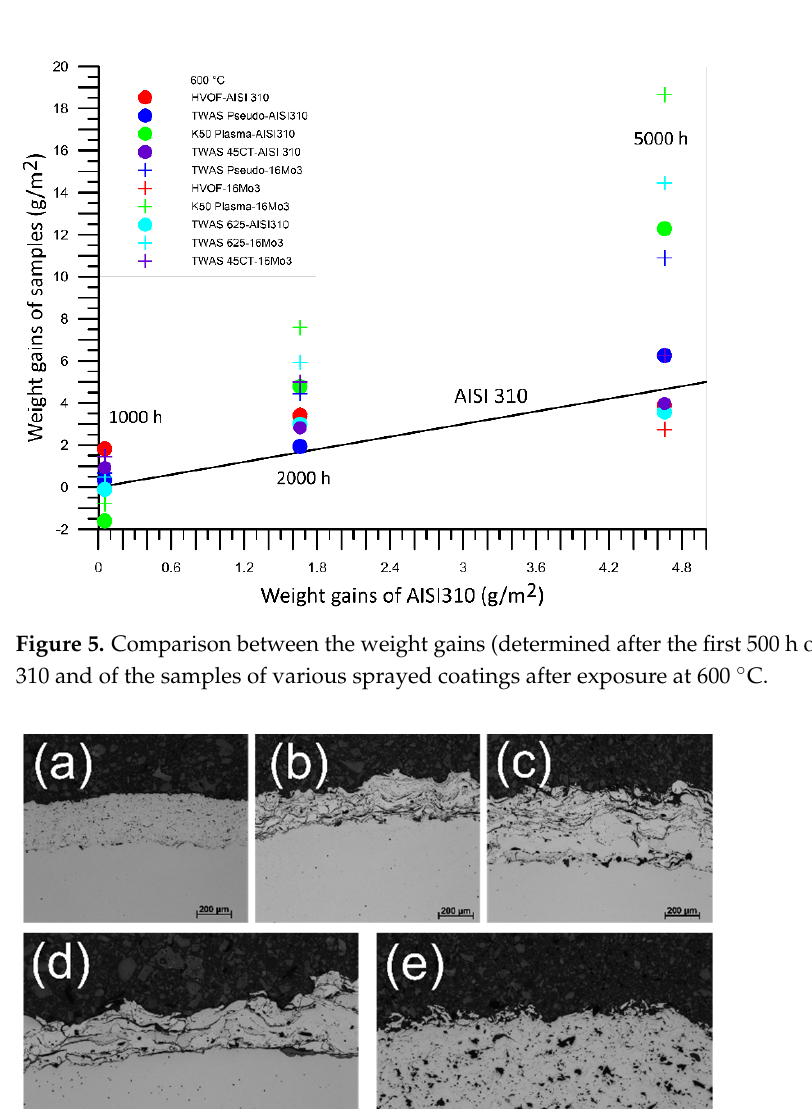
Figure 7. Optical light micrographs of the thermally sprayed coatings after 5000 h at 600 °C in model atmosphere: ( a ) HVOF Amperit 469, ( b ) TWAS 45CT, ( c ) TWAS Alloy 625, ( d ) TWAS pseudo ‐ alloy, and ( e ) Plasma K50—16Mo3 steel base material. 3.3. SEM/EDS and EMPA Results Figures 8–11 show the SEM/EDS analysis of the coating samples after laboratory ex ‐ posure for 5000 h at 600 °C in an environment containing sulfur dioxide and hydrogen chloride. In all cases, these coatings were on a 16Mo3 substrate. An electron microscope with an EDS analyzer was used for an overview analysis of the distribution of the indi ‐ vidual elements in the coatings, and the elemental maps for each tested coating are shown next to the microstructures (in the case of the TWAS method, only the pseudo ‐ alloy and